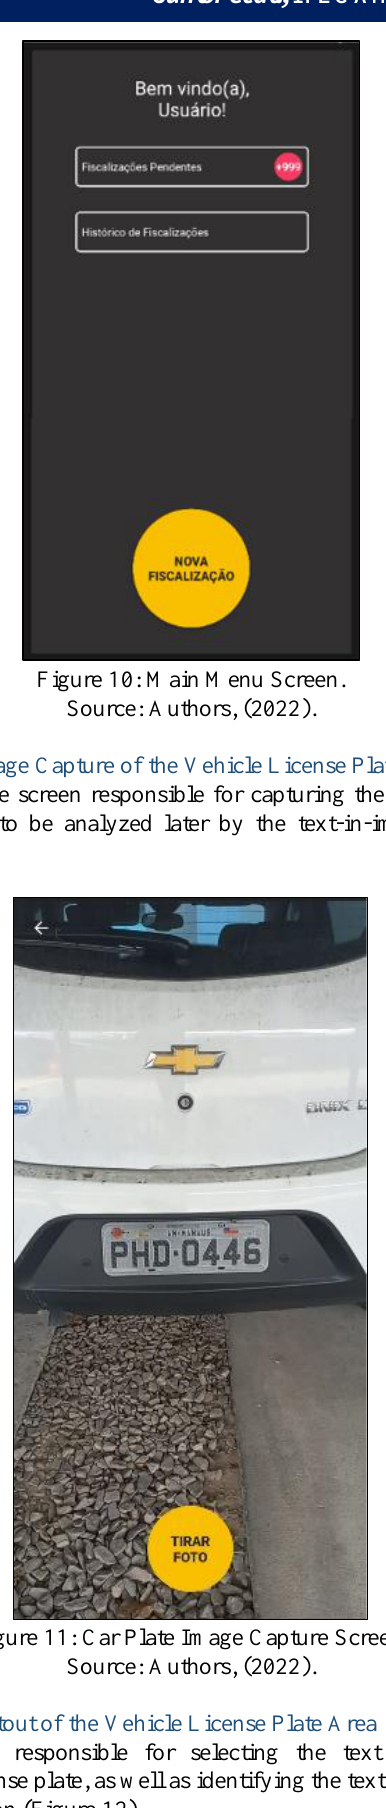
Figure 13: Inspection Details